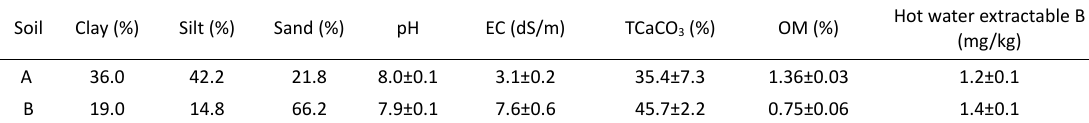
Table 3: Main soil properties